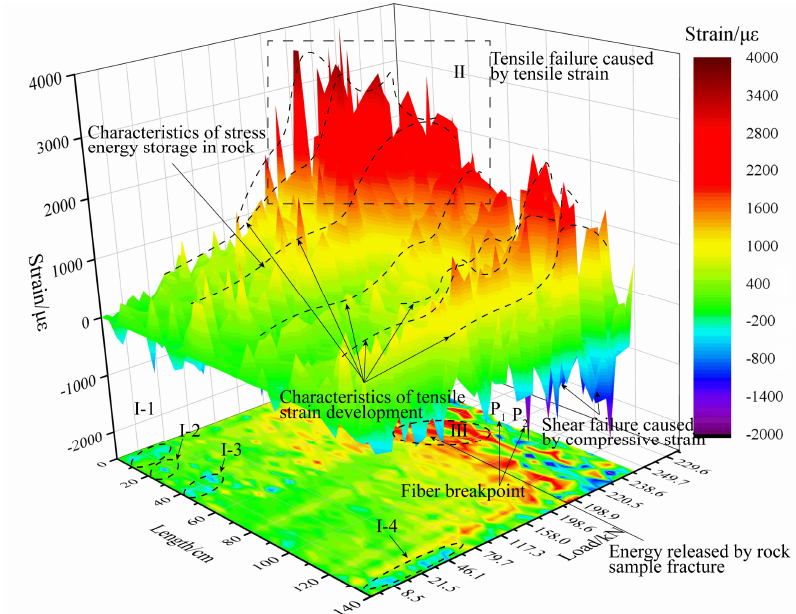
Figure 10. Strain test results of No.3 rock sample with distributed optical